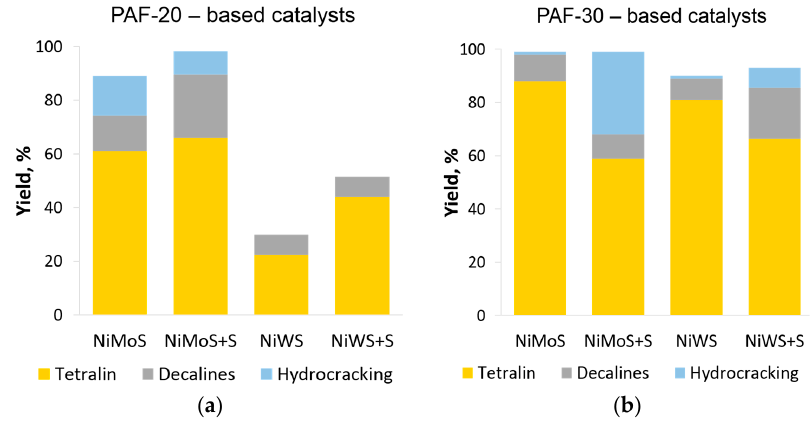
Figure 8. Product yield distribution for all catalytic systems: ( a ) PAF ‐ 20 ‐ based catalysts; and ( b ) PAF ‐ 30 ‐ based catalysts.